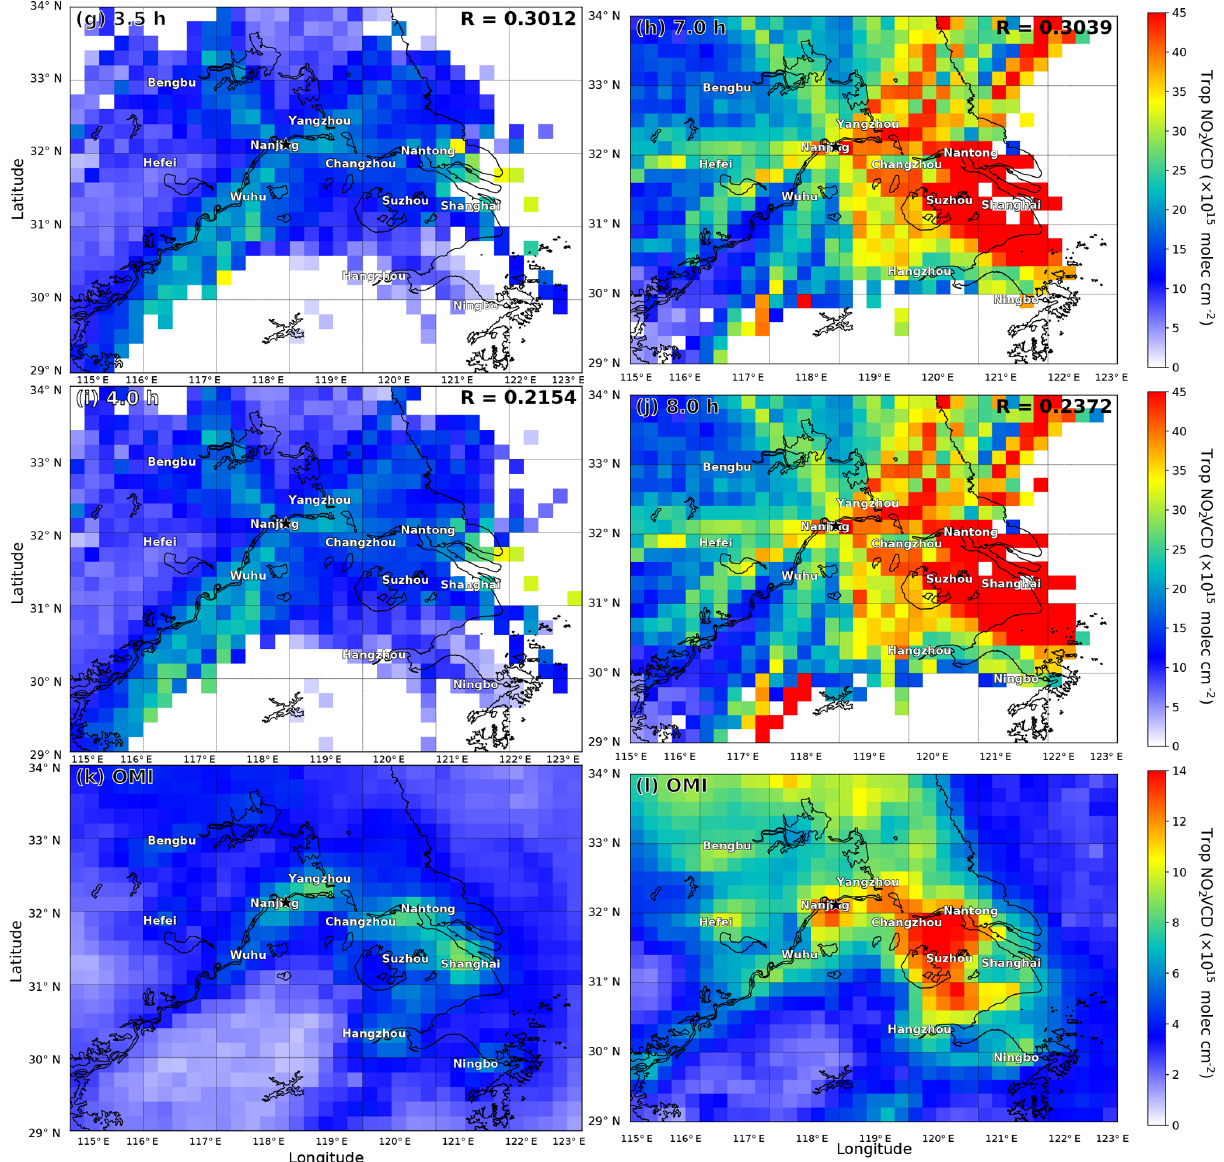
Figure 10. Spatial distribution of NO 2 in summer (left panels) and winter (right panels) reconstructed from the MAX-DOAS measurements using different assumed lifetime. The average OMI NO 2 vertical column densities during summer and winter are shown in (k) and (l) , respec- tively. The corresponding lifetimes used in the calculation and the spatial correlation between the reconstructed maps and OMI observations are indicated each